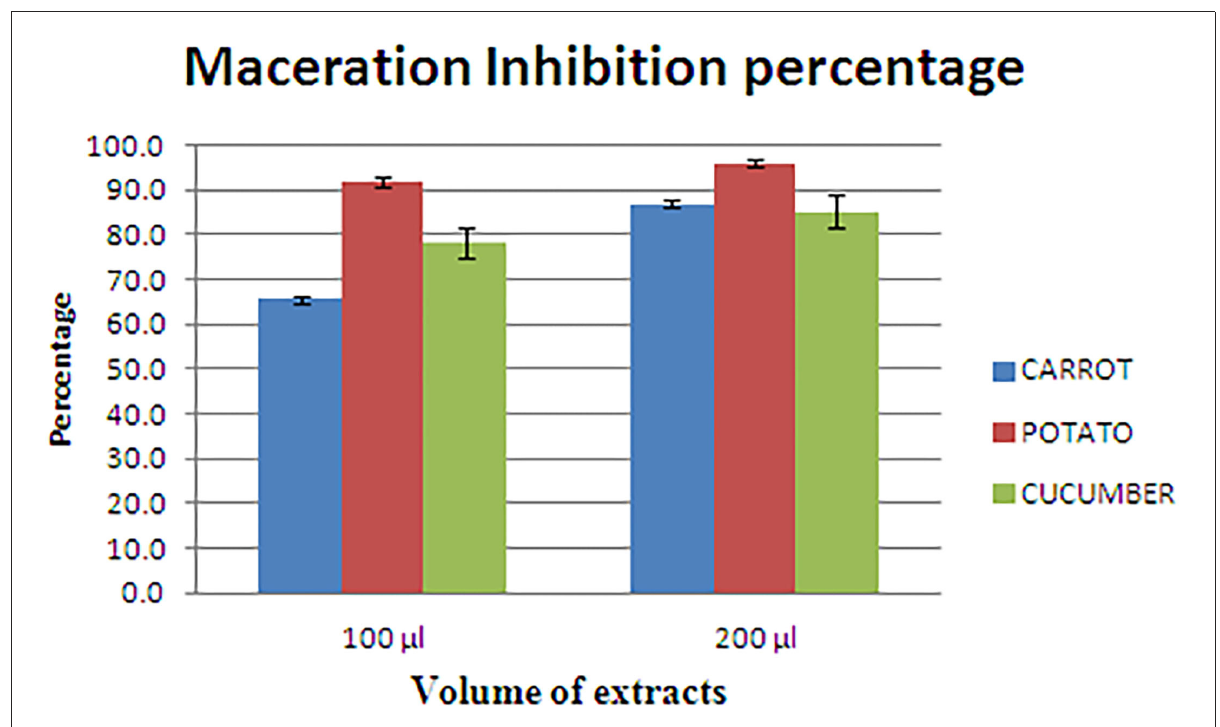
FIGURE9 Maceration inhibition assay of potato, carrot, and cucumber using RB